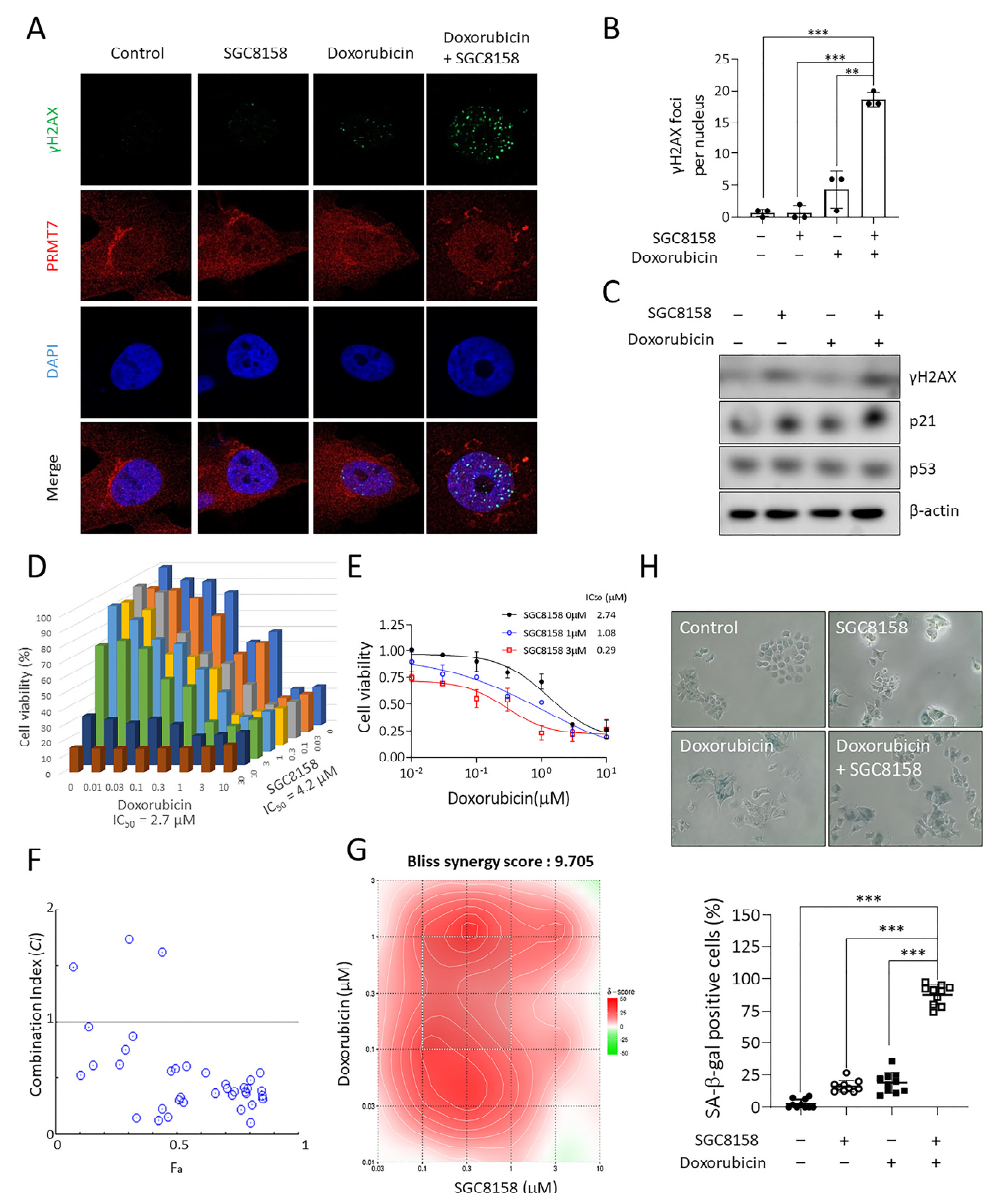
Figure 5. SGC8158 potentiates doxorubicin-induced DNA damage response and its cytotoxicity. After 2 days treatment of MCF7 cells with the combination of 0.01 μ M doxorubicin and 5 μ M SGC8158, ( A ) γ H2AX foci were visualized using confocal microscopy (630× magnification) and ( B ) quantification of cells showing high fluorescence of γ H2AX was performed using image processing software ( n = 3). ** p < 0.01 and *** p < 0.001. ( C ) In the same conditions, the γ H2AX levels were measured using western blotting. ( D – G ) MCF7 cells were treated with a combinatorial setting of SGC8158 and doxorubicin. ( D ) Cell viabilities were evaluated by an MTT assay. ( E ) The synergistic effects were assessed by comparing the IC 50 of doxorubicin in the presence of SGC8158 (1 or 3 μ M). ( F ) The CI values were calculated using CompuSyn software. ( G ) The Bliss synergy score was calculated using the Bliss independence model. The gradation of the red regions indicates the intensity of synergism. ( H ) Representative images illustrating SA ‐β‐ gal ‐ positive cells under the experimental setting (A) (100× magnification). Percentage of SA ‐β‐ gal ‐ positive cells was shown as means ± SD ( n = 10). *** p < 0.001. MTT: 3 ‐ (4,5 ‐ dimethylthiazol ‐ 2 ‐ yl) ‐ 2,5 ‐ diphenyltetrazolium bromide; CI: combination index; SD: standard deviation.